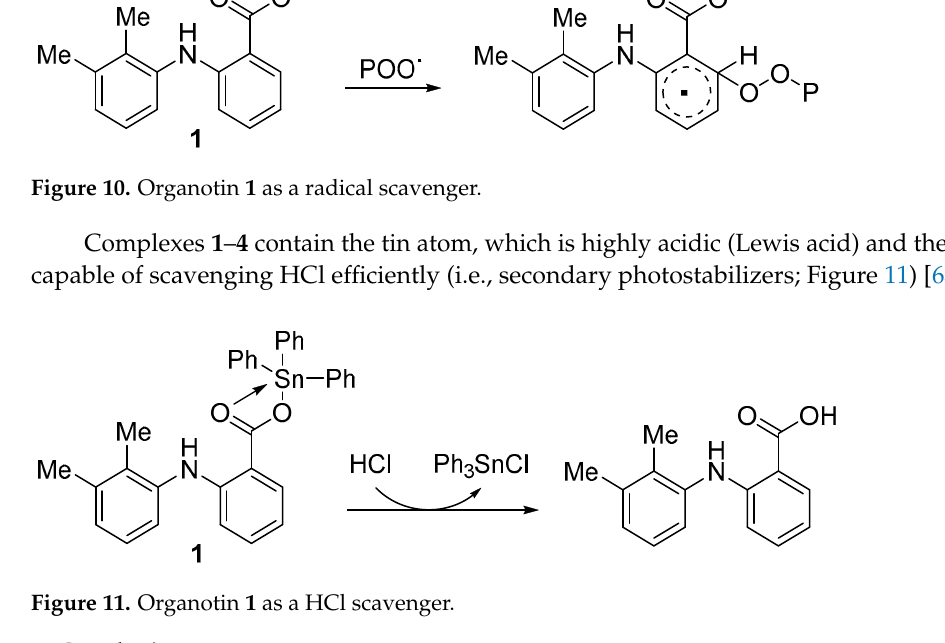
Figure 11. Organotin 1 as a HCl scavenger.